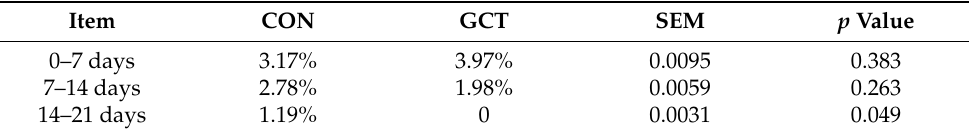
Table 3. Effect of GCT on diarrhea rate during the post weaning period in piglets.